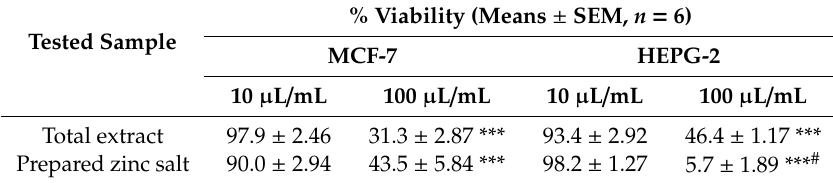
Table 2. In vitro cytotoxic assay using breast cell line MCF-7 and hepatoblastoma HEPG-2 human cancer cell